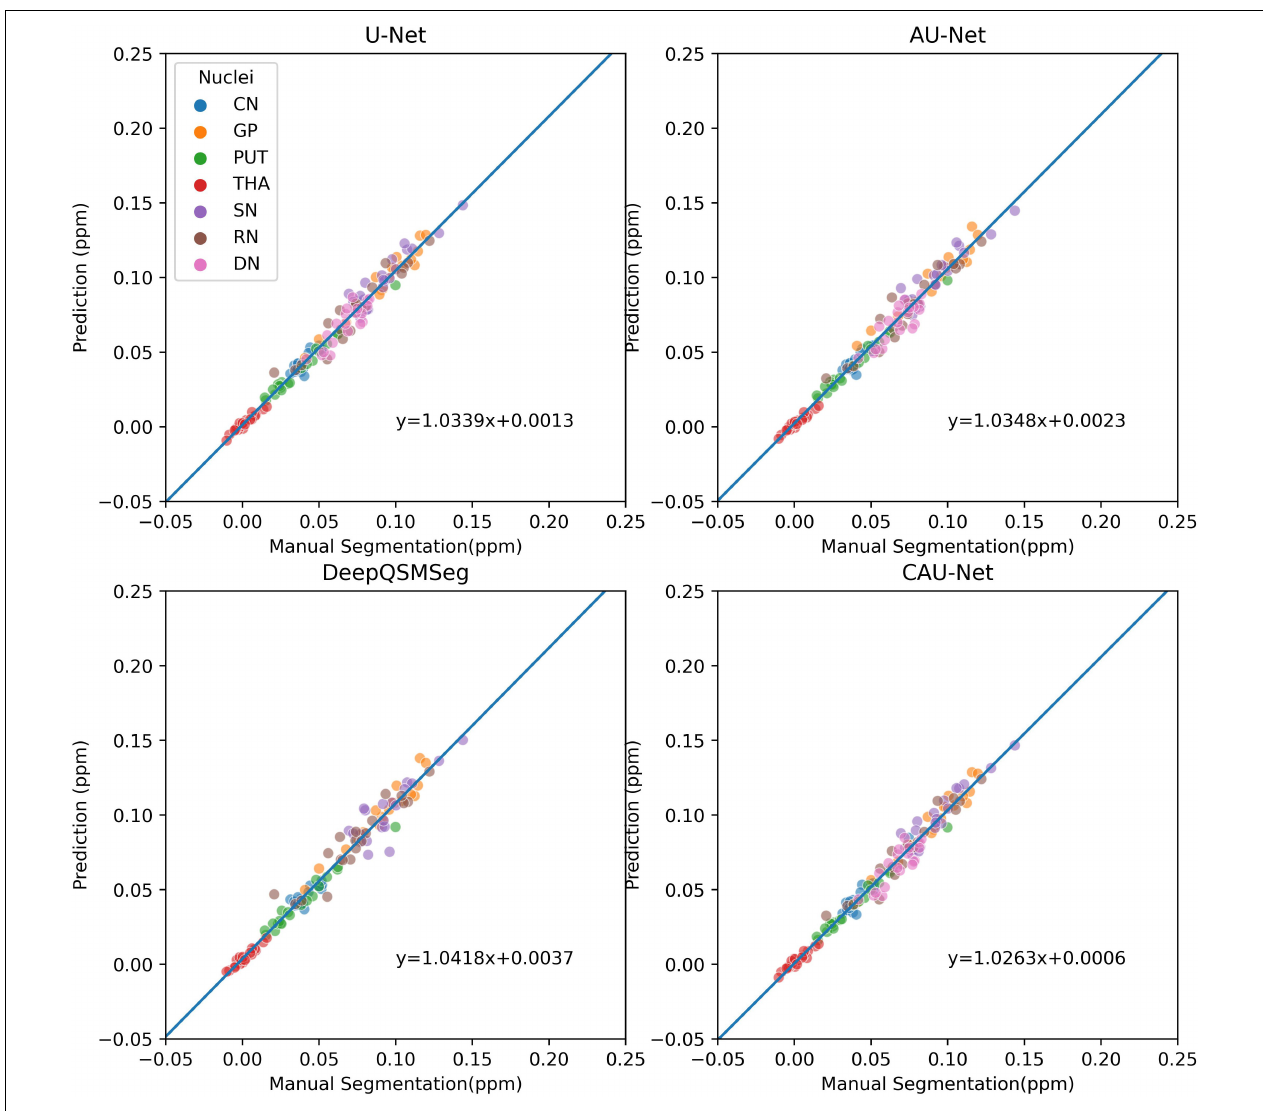
FIGURE 9 | Scatter plot of susceptibility values measured from manual segmentations and automatic segmentations on the subjects of the Dataset II. The correlation lines are also plotted. For DeepQSMSeg, we omitted the results on